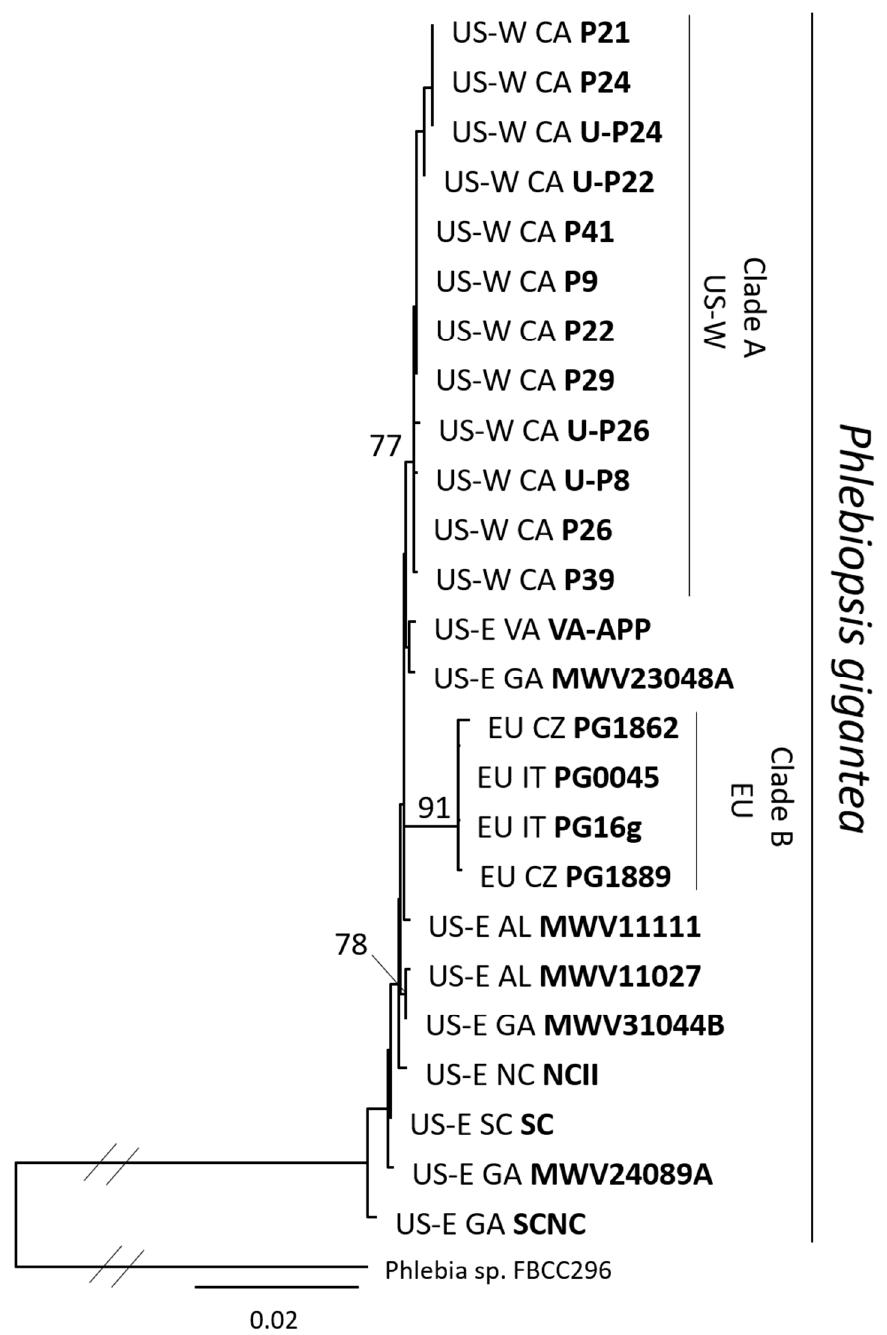
Figure 11. Maximum Likelihood phylogram obtained from the TEF1- α , nrITS, RPB1 , RPB2 and GPD (IV and V introns only) combined sequence alignment . Phlebia sp. (FBCC296) was used as outgroup taxon. Only MLB values ≥ 70% are given above clade branches.